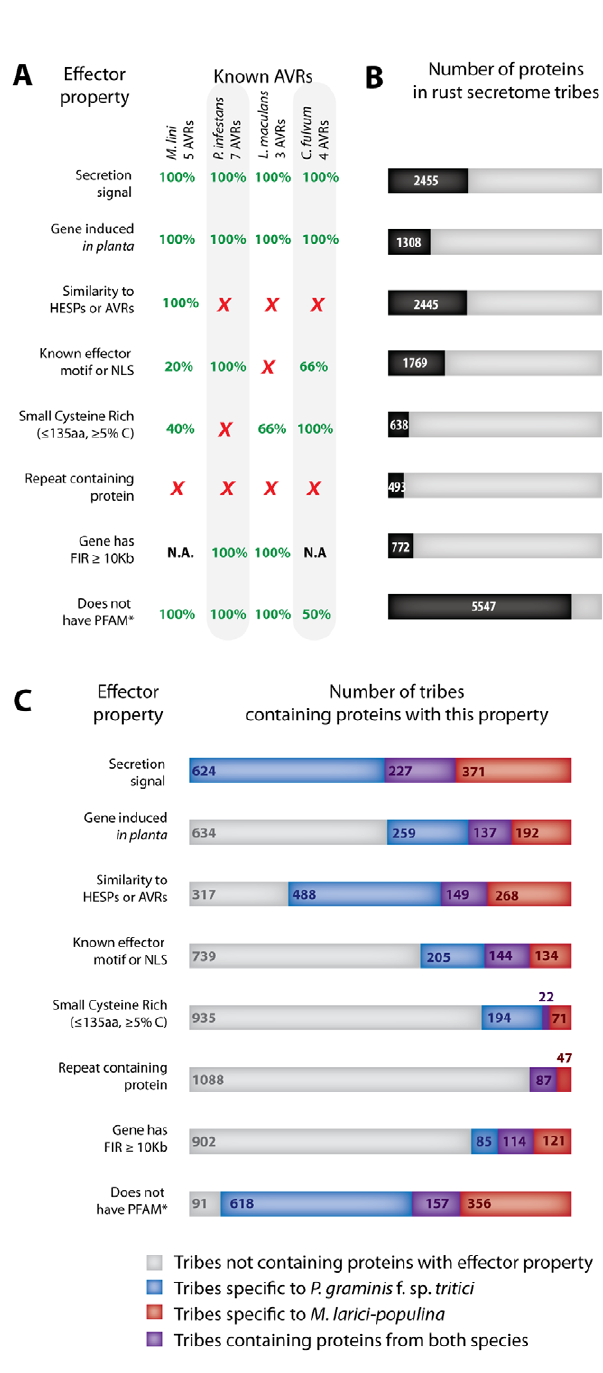
Figure 4. Distribution of effector features in the M. larici- populina and P. graminis f. sp. tritici secretome proteins and tribes. (A) Percentage of known avirulence effectors (AVRs) from M. lini , P. infestans , L. maculans and C. fulvum showing each effector property. A red cross indicates no match; N.A., not available. (B) Number of proteins grouped in secretome tribes showing each one of eight effector properties. Numbers on charts refers to total number of proteins. (C) The distribution of eight effector features in core and lineage-specific secretome tribes of rust fungi. *Five PFAM domains associated with pathogenicity and enriched in secretome tribes of rust fungi (Table 1) and PFAM-B domains were permitted.